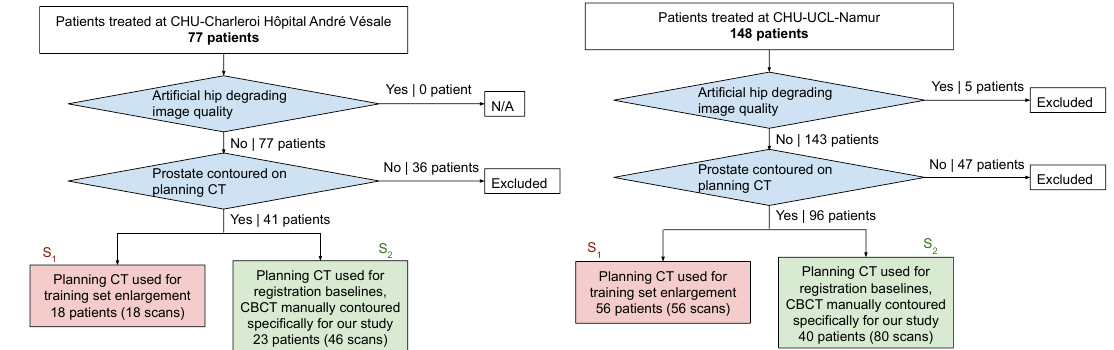
Figure 2. Case selection from CHU-Charleroi Hôpital André Vésale and CHU-UCL-Namur.